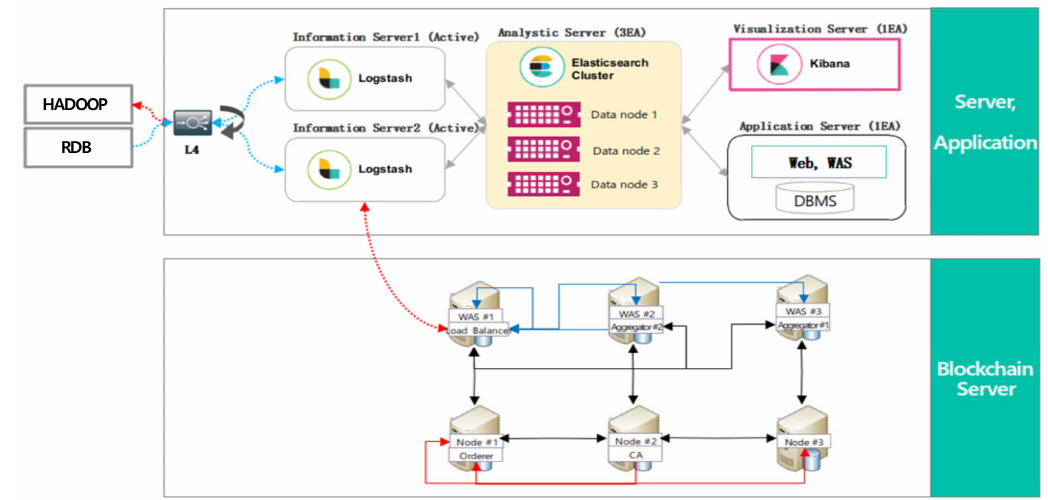
Figure 7. Structure of blockchain-based DR simulation-based